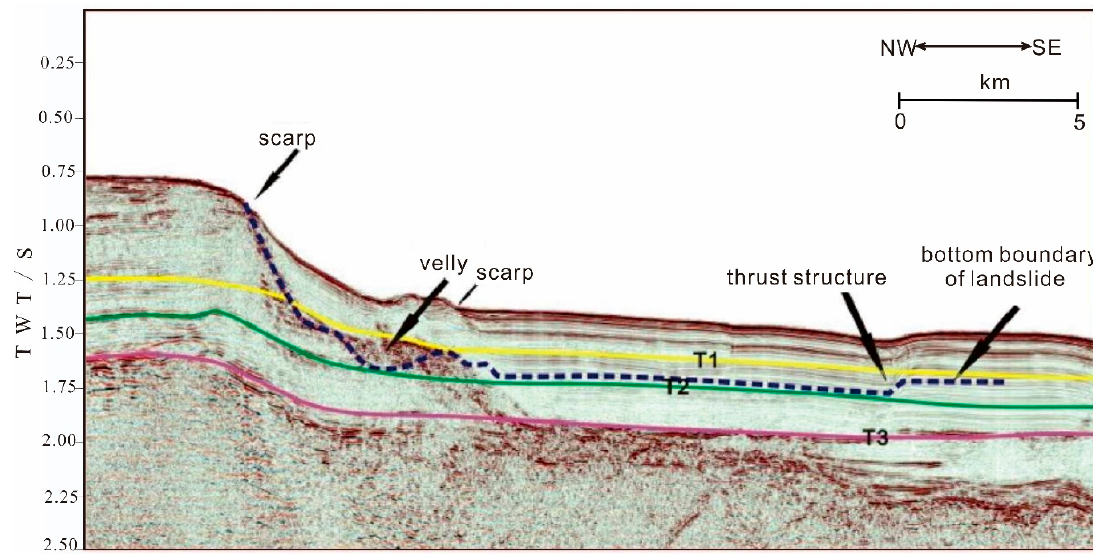
Figure 2. Seismic reflection of landslide of Line 1 on the northern slope of South China Sea.